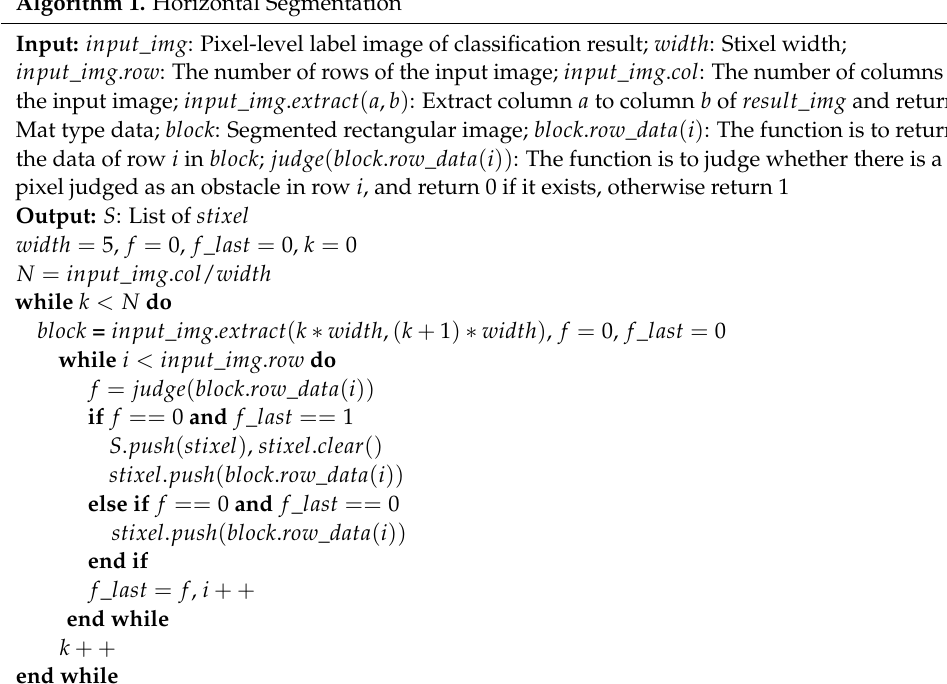
Algorithm 1. Horizontal Segmentation